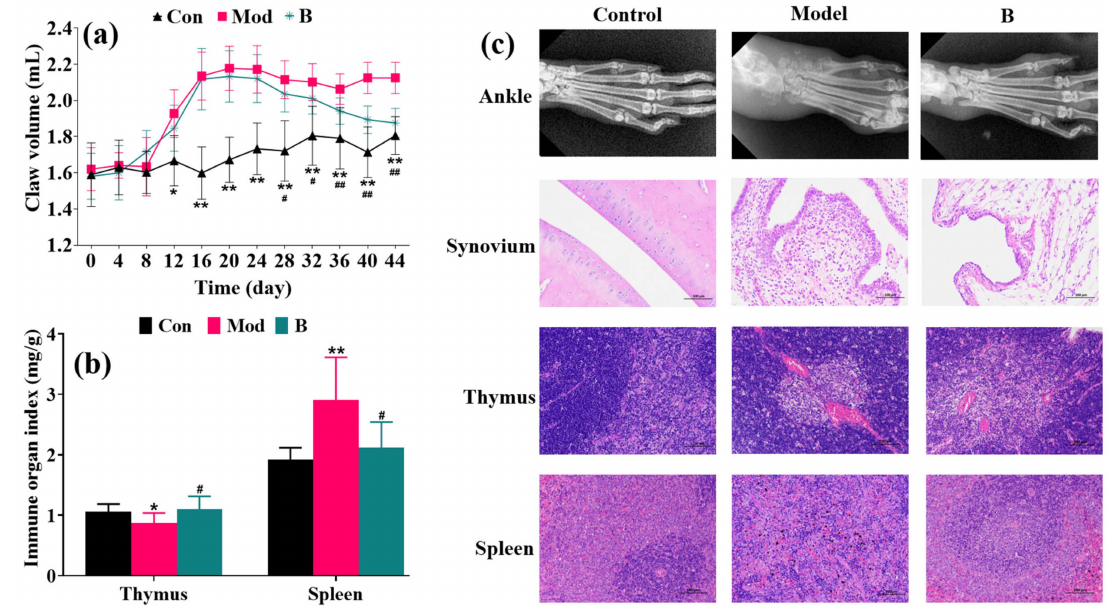
Figure 2. The physical signs measured during model preparation, showing the results of histological pathology ( × 200) and X-ray examination after 28 days of oral administration of B. ( a ) Claw volume. ( b ) Indexes of the spleen and thymus. ( c ) X-ray and histological pathology. * p < 0.05. ** p < 0.01 vs. control group. # p < 0.05. ## p < 0.01 vs. model group.